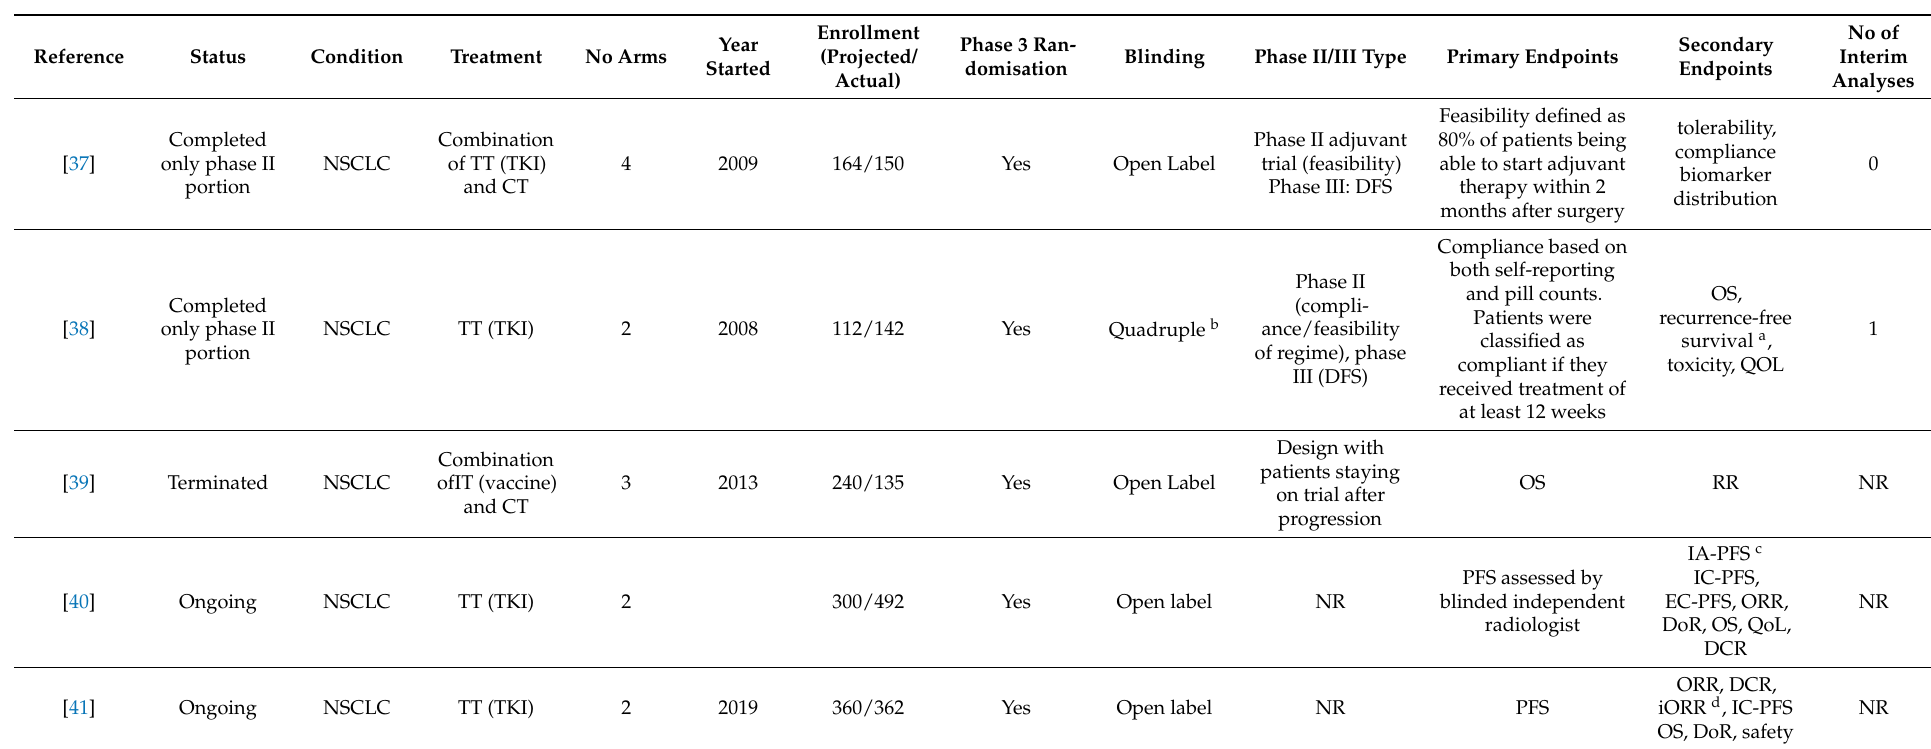
Table 5. Trials with other study